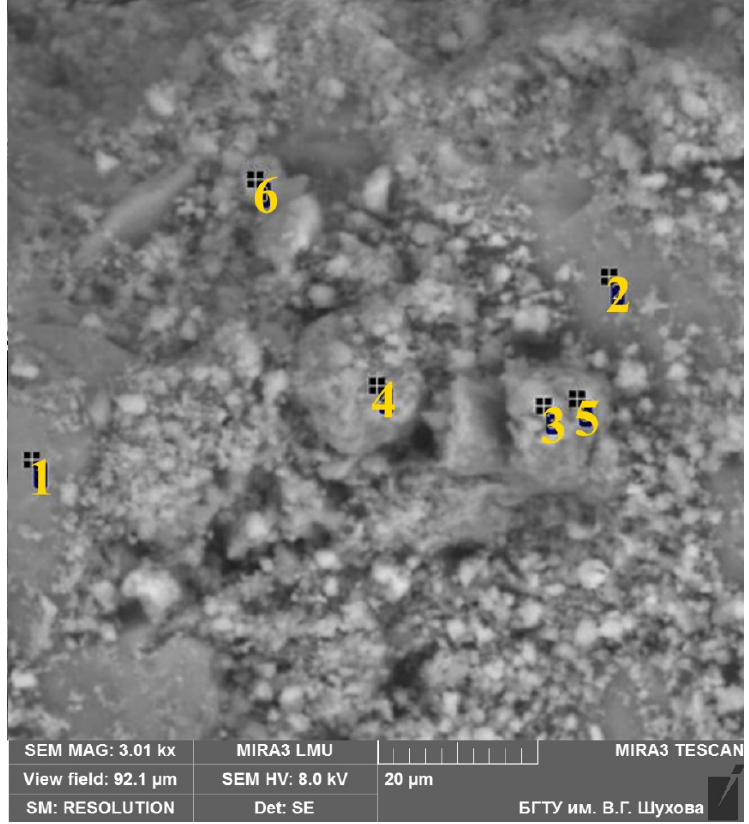
Figure 7. Typical microstructure of the AAM (sample TM1). 1–6—spots of analysis from Table 3. Table 3. Results of typical microphases analysis (spots of analysis are in the Figure 7).